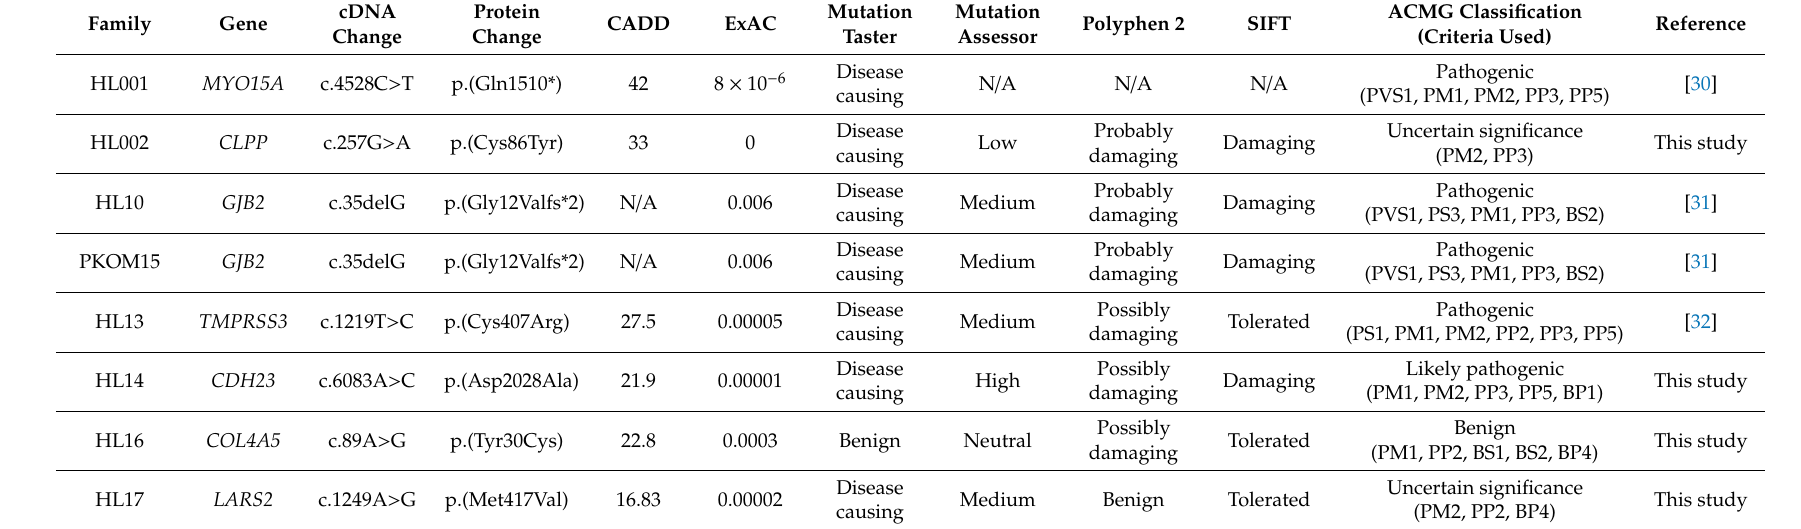
Table 1. Genes, identified variants, and their ACMG